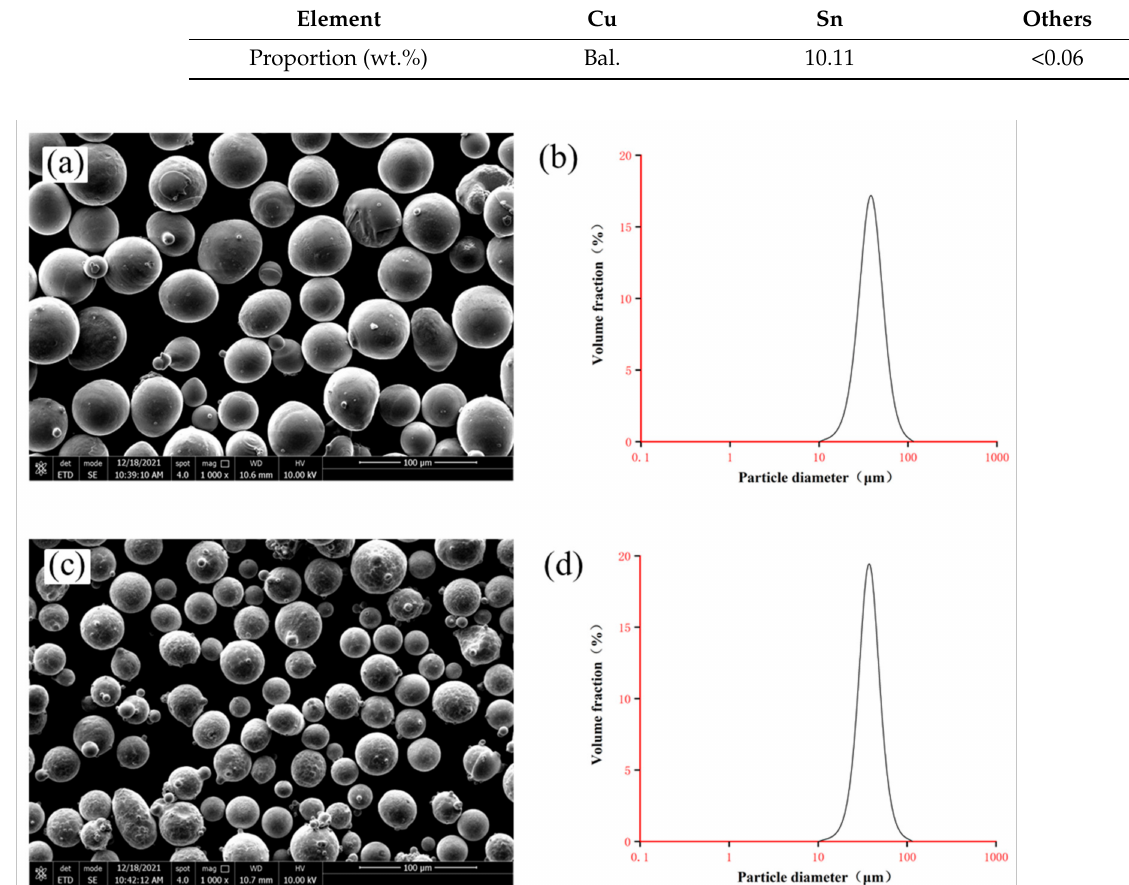
Figure 1. ( a ) SEM image of equiatomic NiTi50 powder (1000 × ); ( b ) particle size distribution for equiatomic NiTi50 powder; ( c ) SEM image of CuSn10 powder (1000 × ); ( d ) particle size distribution for CuSn10 powder.